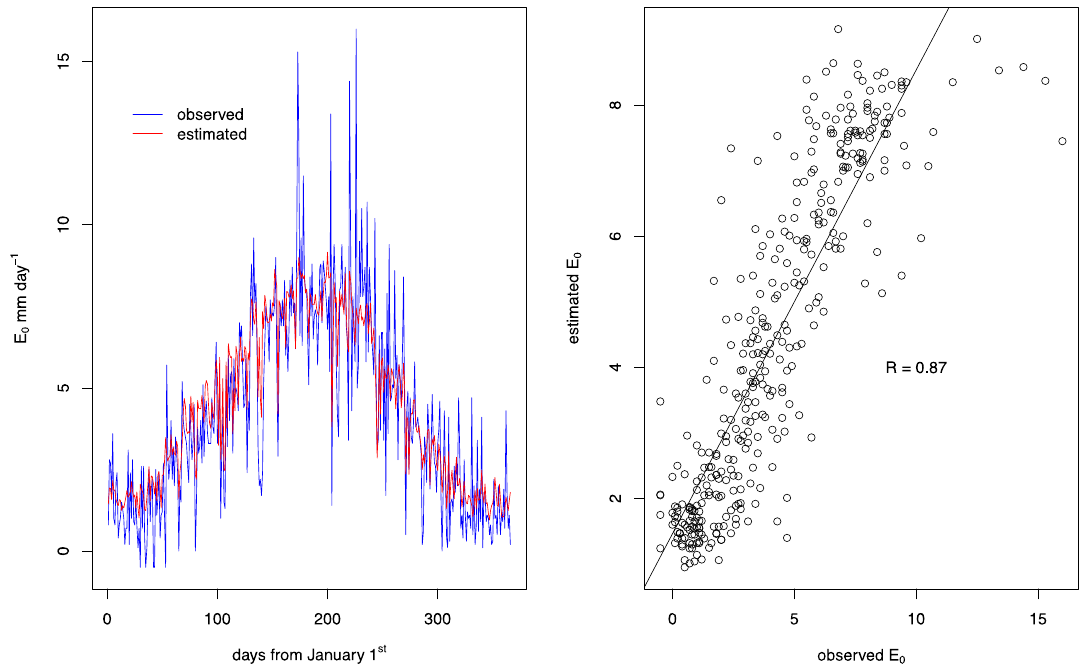
Figure 3. Estimated versus observed evaporation ( (cid:1831) (cid:2868) ) in Palma for 2008.